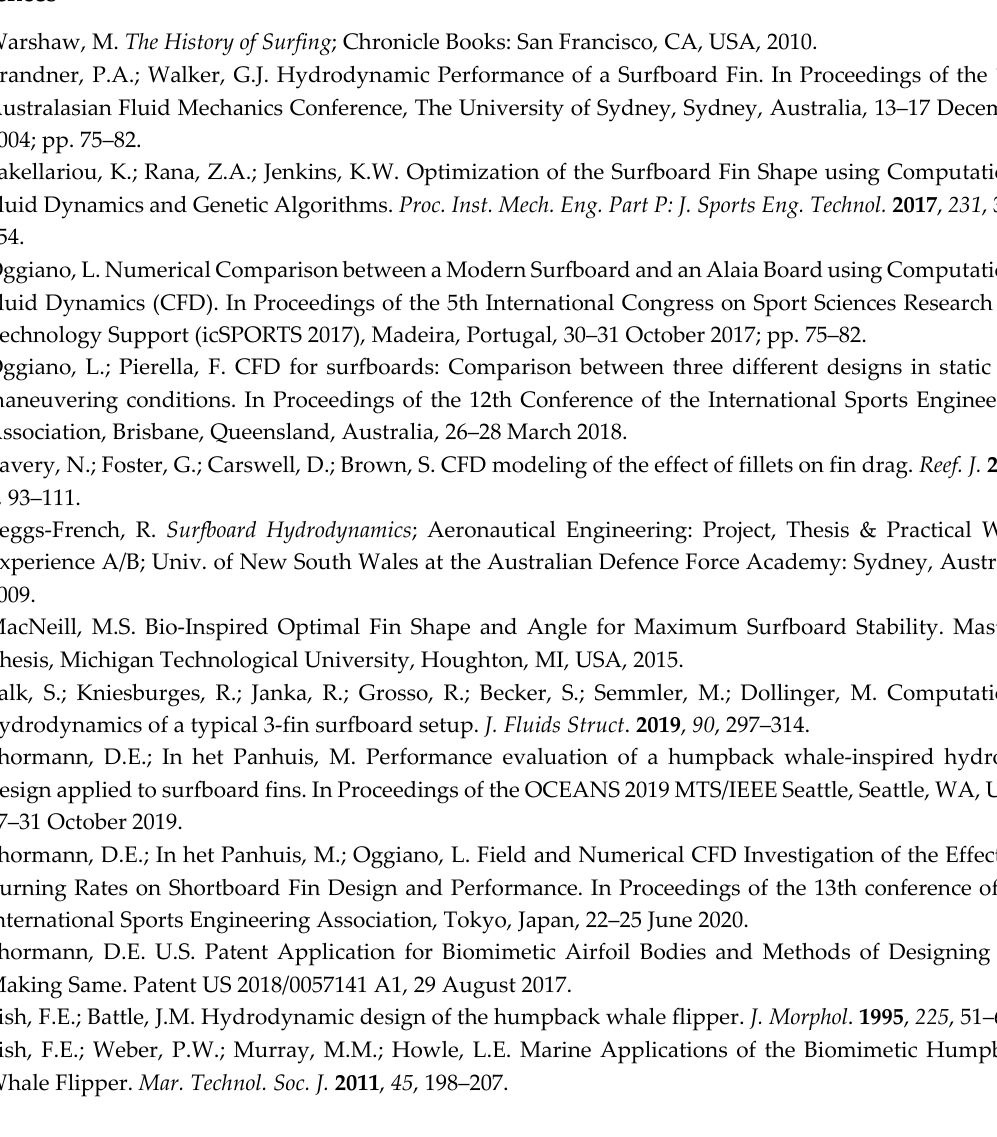
Bottom turn and cutback maneuvers, Table S1: Matrix of speeds and rotation rates used in CFD simulations, Table S2: Surfboard fin specifications, Table S3: Mean resultants, forces and directions for all fins, Table S4: Times for onset of stall in 3-fin sets, Video S1: Intermediate C.mp4, Video S2: Intermediate RW.mp4, Video S3: Intermediate CR.mp4, Video S4: Expert C.mp4, Video S5: Expert RW.mp4, Video S6: Expert CR.mp4, Video S7: WCT C.mp4, Video S8: WCT RW.mp4, Video S9: WCT